Question: Author a descriptive caption for the visualization shown.
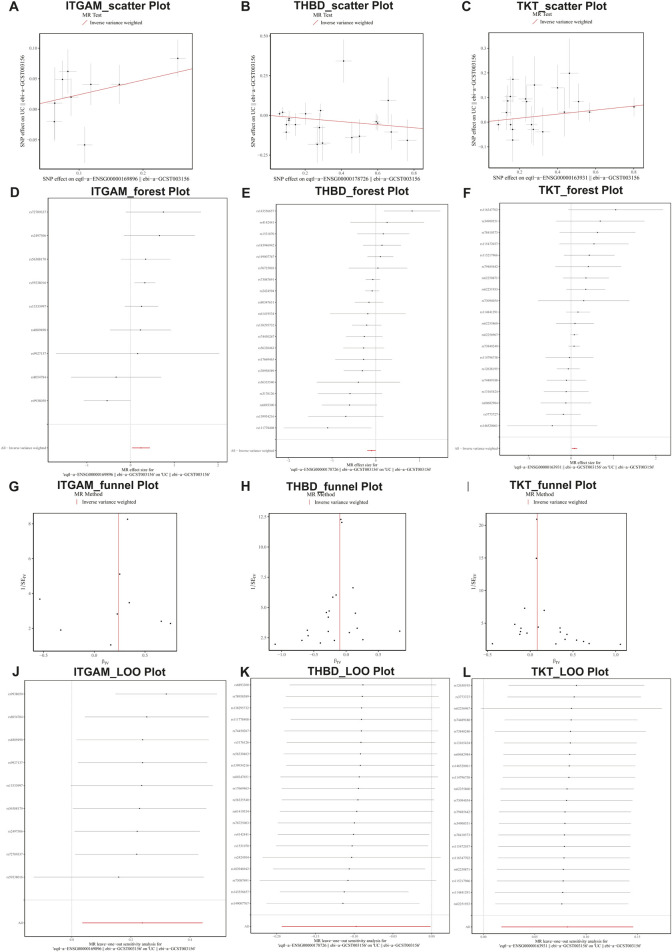
Answer: Three potential biomarkers with genetic correlations to SLE were identified through Mendelian randomization (MR) analysis (A–C) Scatter plots of the inverse-variance weighted (IVW) method demonstrated the genetic correlations of THBD, ITGAM, and TKT with SLE, where the fold and intercepts of the vertical coordinates were near zero, indicating minimal confounding effects. (D–F) Forest plots displayed the effect size of the three genes: ITGAM (OR = 1.270, 95% CI = 1.036–1.557, p = 0.021) and TKT (OR = 1.085, 95% CI = 1.018–1.157, p = 0.013) as risk factors, and THBD (OR = 0.907, 95% CI = 0.824–0.999, p = 0.047) as a protective factor for SLE. (G–I) The uniform distribution of the genetic loci on both sides of the midline aligned with Mendel’s second law, further supporting the robustness of the results. (J–L) Leave-one-out (LOO) sensitivity analysis verified the robustness and reliability of the MR analysis, showing that the genetic correlations of THBD, ITGAM, and TKT with SLE remained consistent.